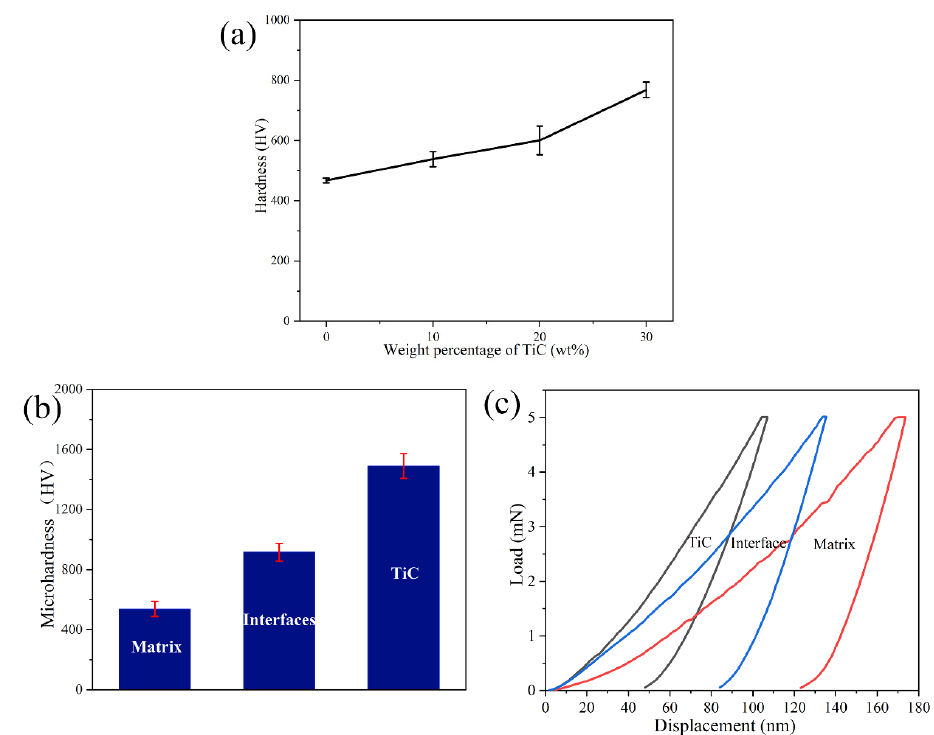
Figure 6. ( a ) Hardness of HEA-TiC composites; ( b ) micro-hardness of different regions in the HEA-10TiC composites; ( c ) load–displacement curves of different regions in the HEA-10TiC composites.